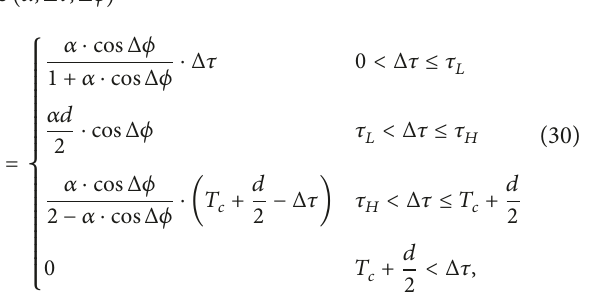
Figure 10: This figure shows the variety of PS C/A code in GPS, the interval of correlators is 𝑑 = 0.25𝑇 𝑐 . (a) is the result of antenna Ashtech. (b) is the result of antenna Trimble.